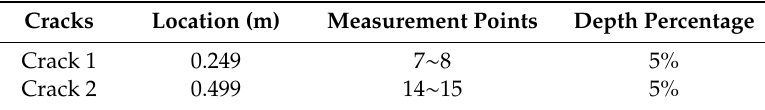
Table 2. Crack information of the numerical